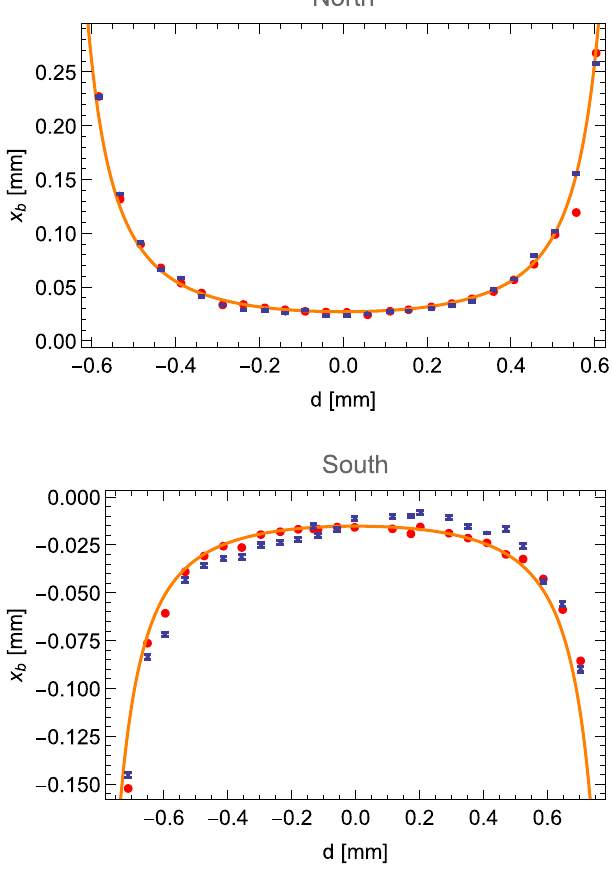
FIG. 7. Measurement of downstream beam offset, x , vs. jaw b tilt parameter, d , for the North (top plot) and South (bottom plot) dechirper jaws. The blue plotting symbols give the measurement points, after they have been shifted vertically by − x , horizon- b 0 tally by − d 0 , of the fitted parameters. The red curve gives the theoretical result assuming b is fixed at b ¼ h b i ¼ 0 . 70 (0.86) mm for the North (South) case. The red symbols give the more accurate theoretical result, obtained from the two- parameter fit to the measured ( δ b , d i i